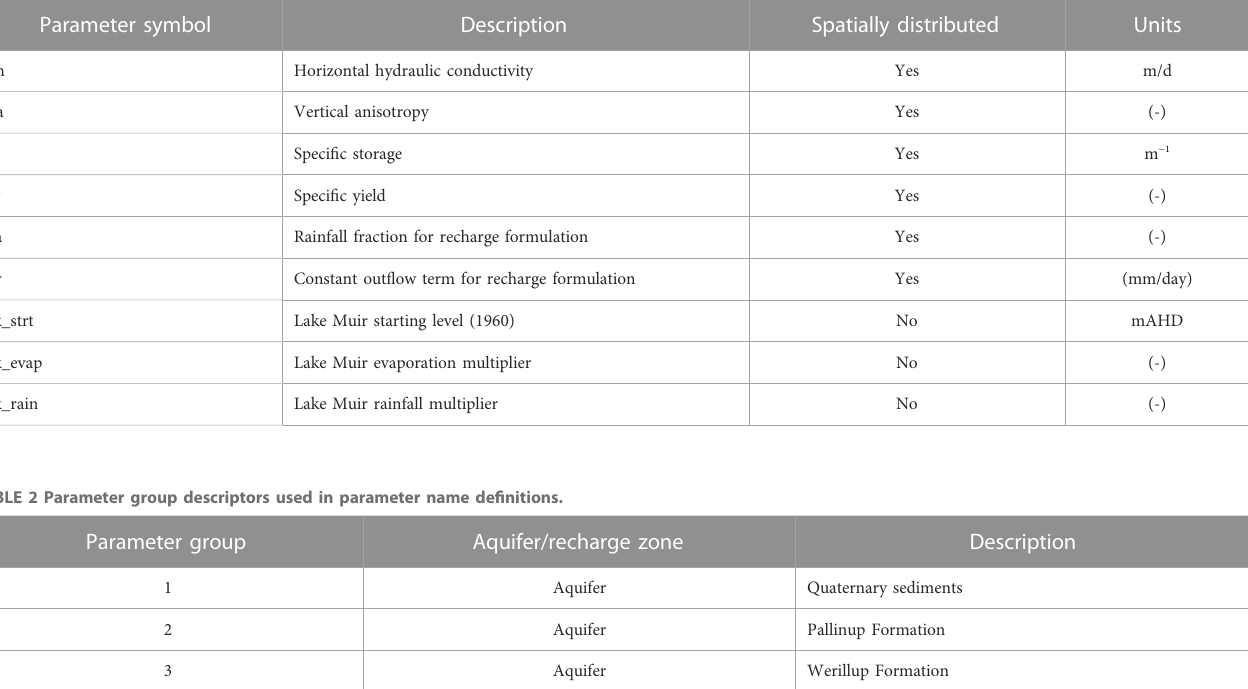
TABLE 1 Parameter type descriptors used in parameter name de fi nition.